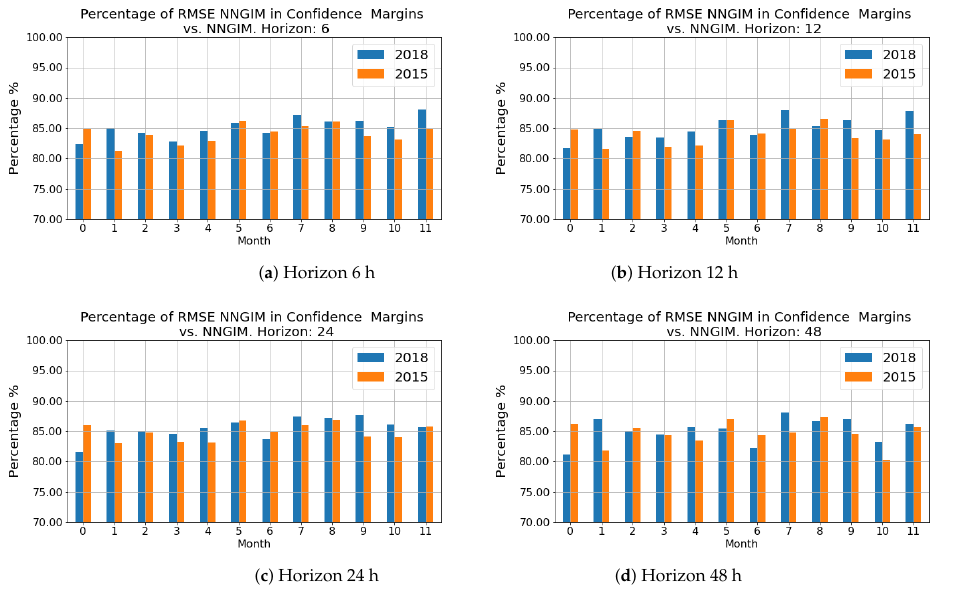
Figure 12. Performance for Forecast ref ⊂ Forecast Map ± Forecast Std with regard to cyclic freezing for the horizons of 6 h, 12 h, 24 h, 48